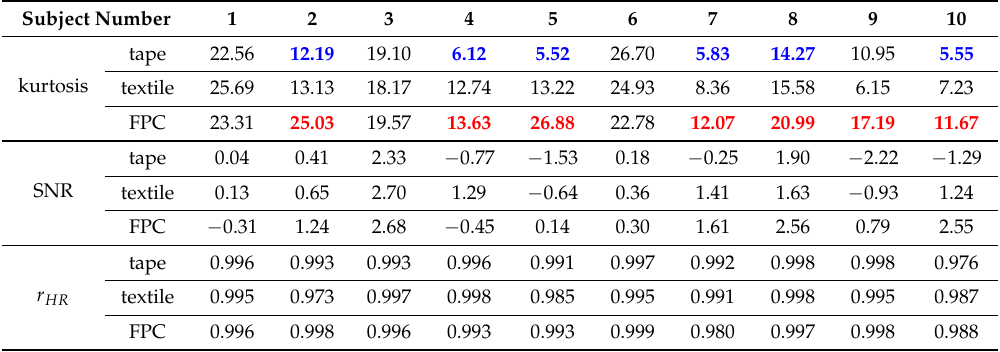
Table 4. Quality indexes of ECG signals measured on a chair. (The blue number show that the kurtosis of the copper foil tape on six subjects is the smallest, and the red numbers show that the kurtosis of the FPC on seven subjects is the